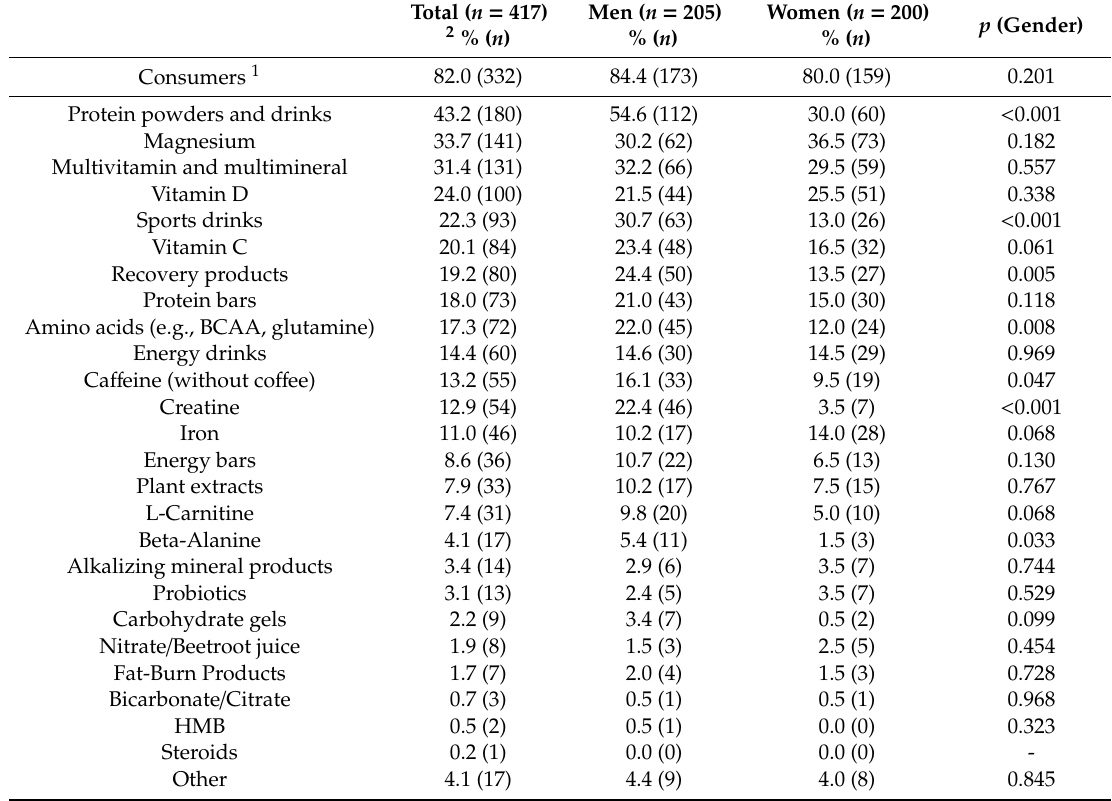
Table 2. Supplement intake by gender as percent and frequency ( n